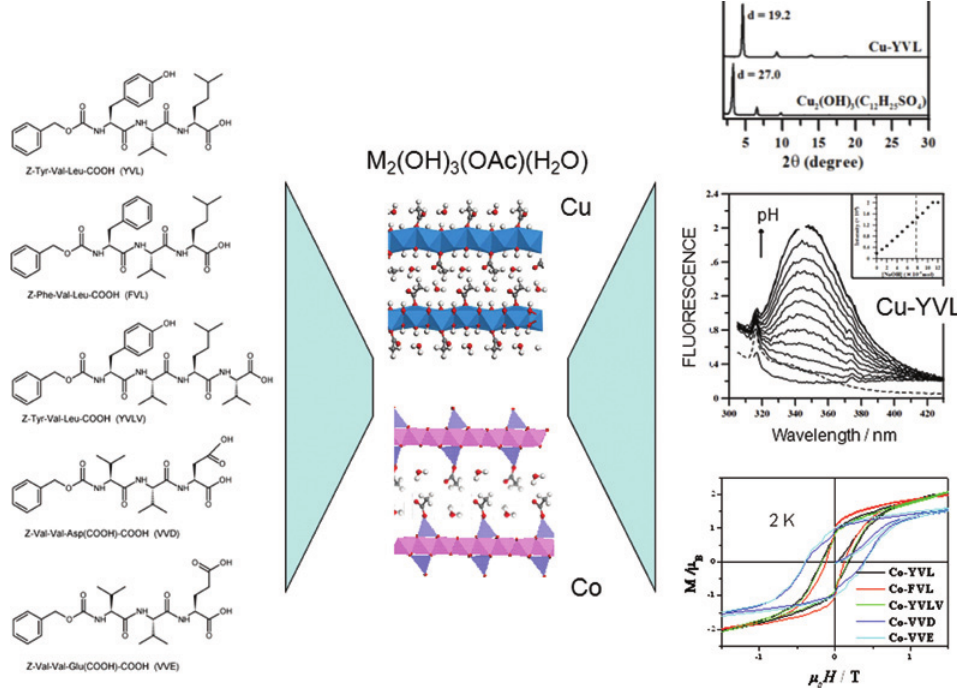
Figure 24: Carboxylate grafted peptides in lamellar hydroxides; structure and physicochemical